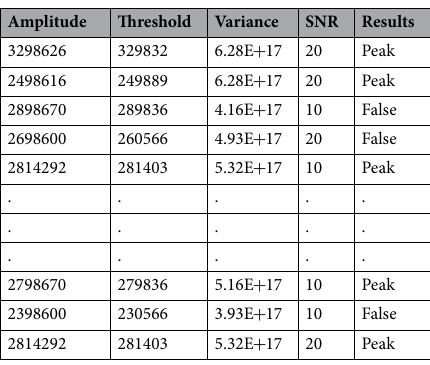
Table 3. Dataset before pre-processing.